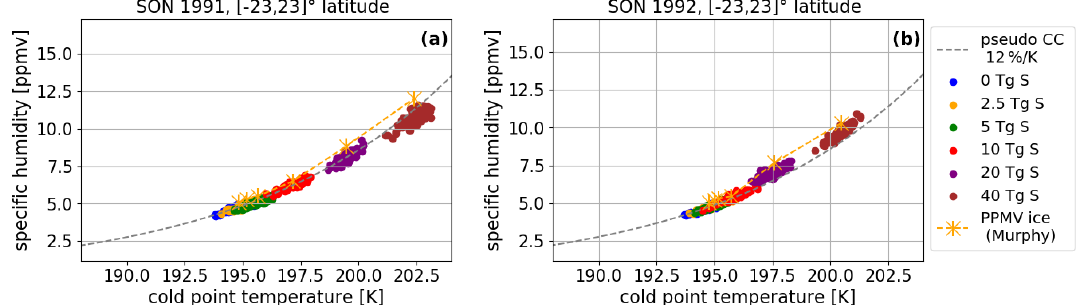
Figure C1. Seasonal averages of specific humidity at cold point as a function of cold-point temperature for SON 1991 (a) and 1992 (b) accounting for the entire tropics. Values for each individual ensemble member are shown as dots for the entire tropics. An approximation (see text) for the Clausius–Clapeyron equation at this temperature range with an 12% increase of specific humidity per Kelvin is indicated by a dashed gray line. The exact solution for the Clausius–Clapeyron equation over ice by Murphy and Koop (2005) is calculated for the average ensemble cold-point temperatures and pressure and shown in